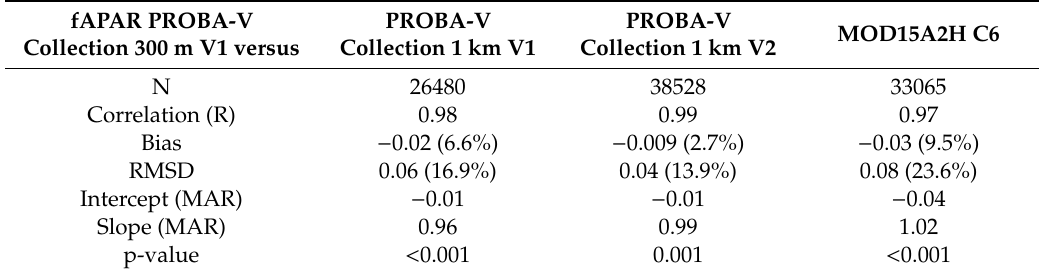
Table 5. fAPAR PROBA-V Collection 300 m V1 versus reference validation metrics computed over all LANDVAL sites for the 2016–2017 period. Relative values (%) are shown in brackets.